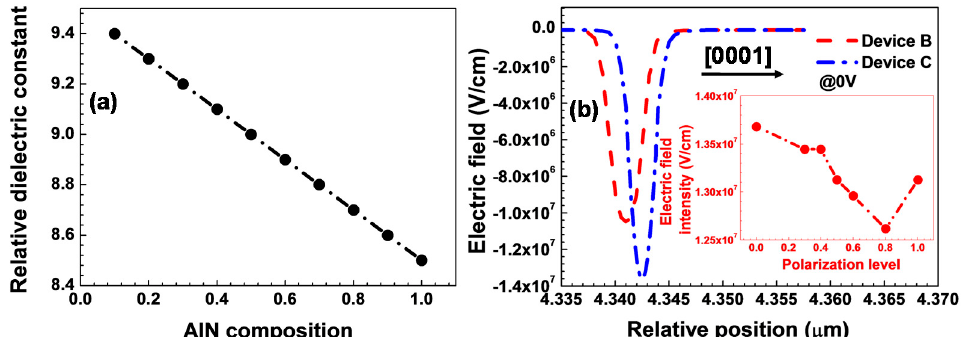
Figure 4. ( a ) Relative dielectric constant of the AlGaN layer in terms of the AlN composition; ( b ) electric field profiles within the tunnel regions for the UV LED (i.e., Device B) with the conventional n + -GaN/p + -GaN tunnel junction and the UV LED (i.e., Device C ) with the DCC tunnel junction. The positive direction for the electric field is along the [0001] direction. The inset shows the electric field intensity as a function of the polarization level. Reproduced from Ref. [67], with the permission of Wiley.